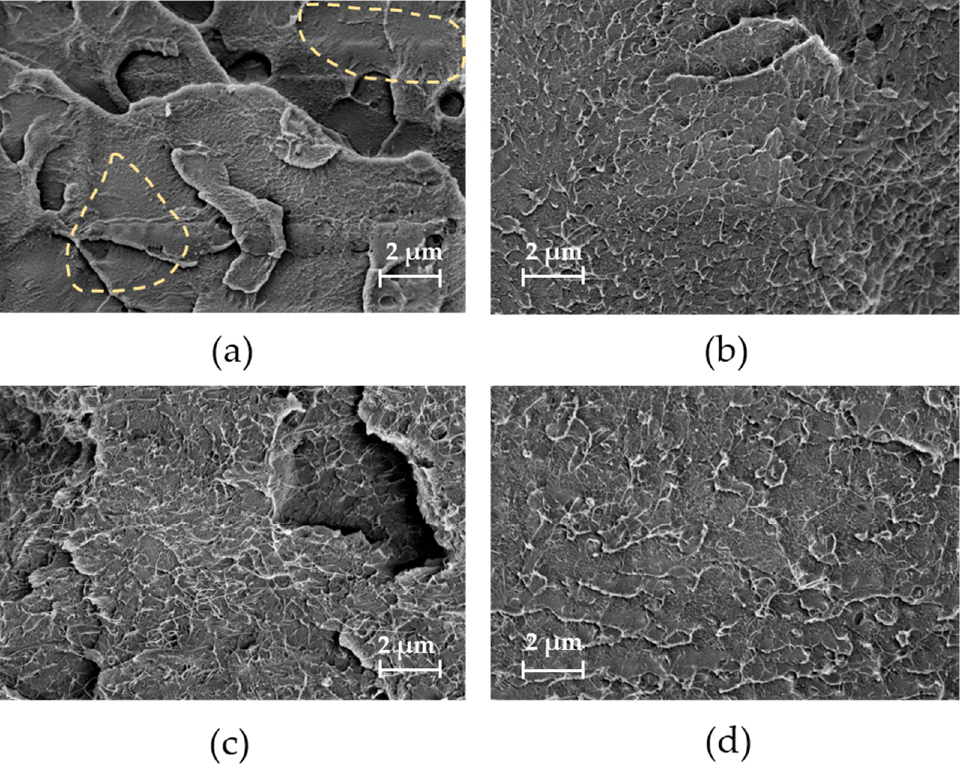
Figure 3. SEM images of cryofractures surface of composites containing 1 wt% SWCNT prepared by direct incorporation at different rotation speeds: ( a ) 50 rpm (dotted lines for highlighting), ( b ) 250 rpm, and masterbatch approach at different rotation speeds. 50 rpm/50 rpm ( c ), at 250 rpm/250 rpm ( d ) (rotation speed at masterbatch preparation/rotation speed at masterbatch dilution)